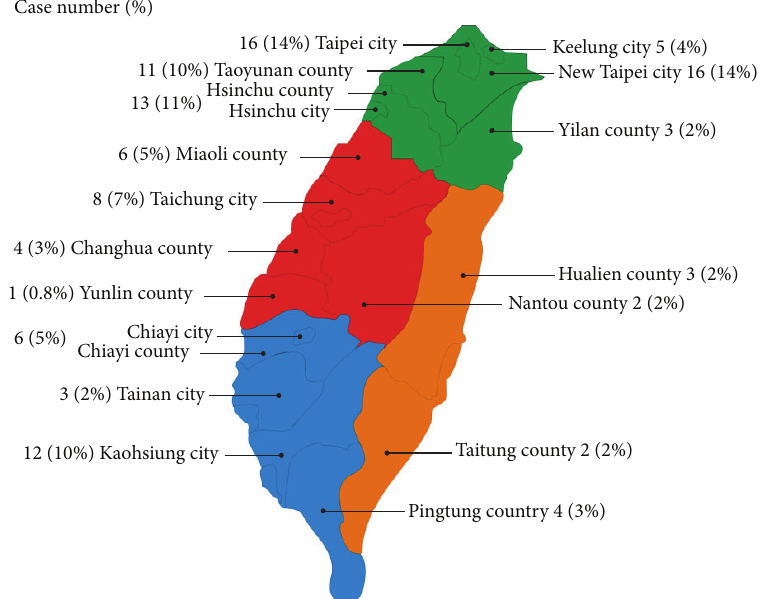
Figure 1: The map of Taiwan shows 19 counties/cities on the main island divided into 4 areas (north in green, center in red, south in blue, and east in orange).